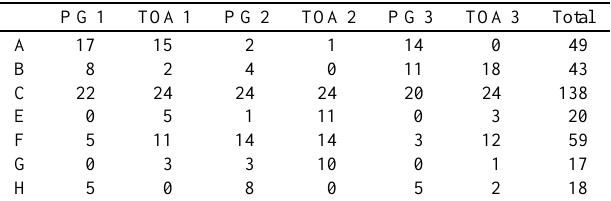
Table 5 Parameter contribution scores, sorted by feature